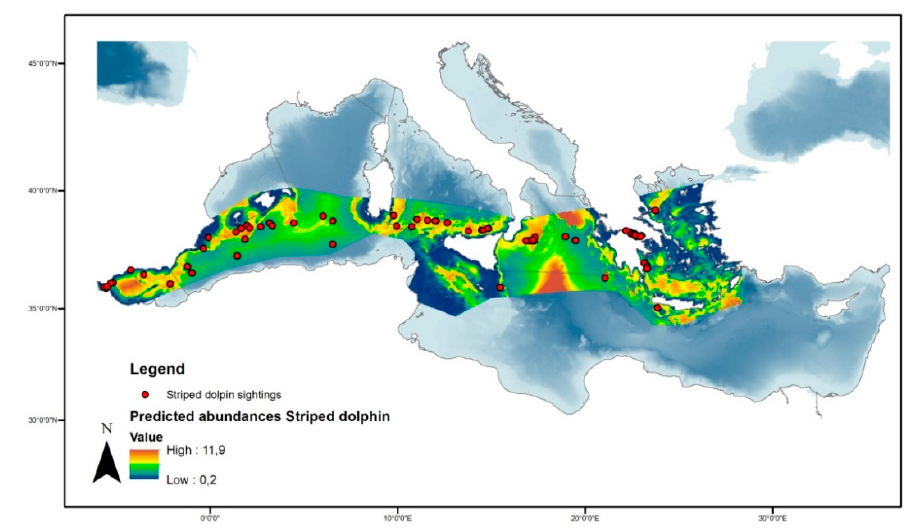
Figure 5. Spatial prediction of abundance for striped dolphins per cell in the studied area.